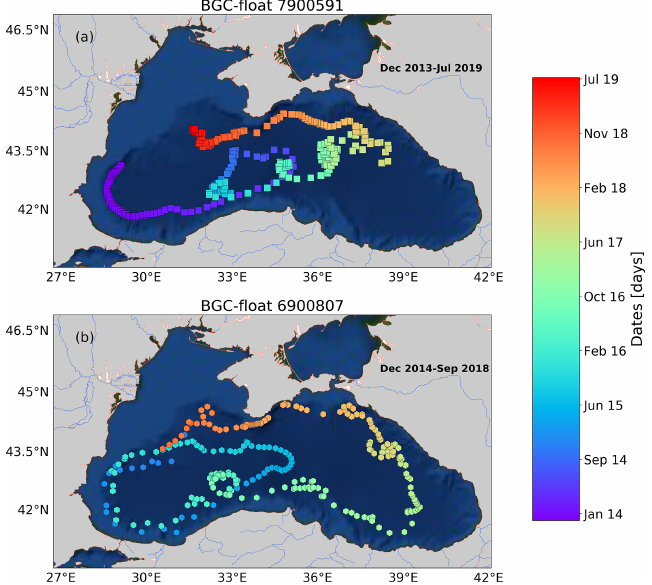
Figure A1. Sampling locations of floats (a) 7900591 and (b) 6900807 between December 2013 and July 2019. Colored squares and hexagons indicate the date (color bar) for a given profile of floats 6900807 and 7900591, respectively.